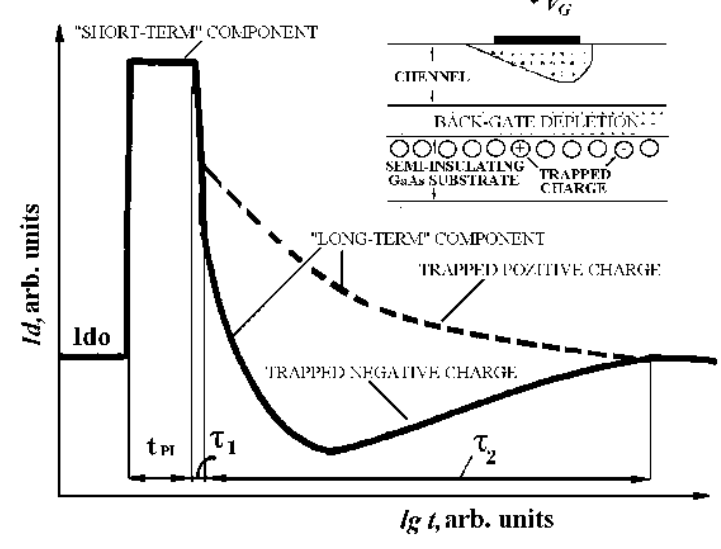
Fig. 2. The typical drain current radiation response of GaAs FET